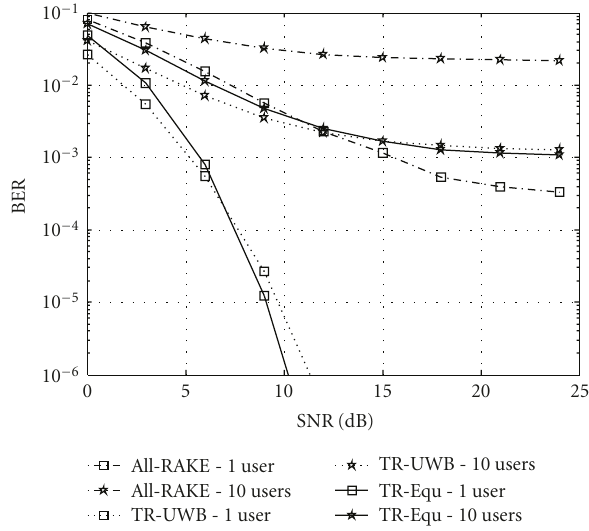
Figure 12: BER curves for 1-user and 10-user cases with linear con- gruence coding at 30Mbit/s, N s = 5.